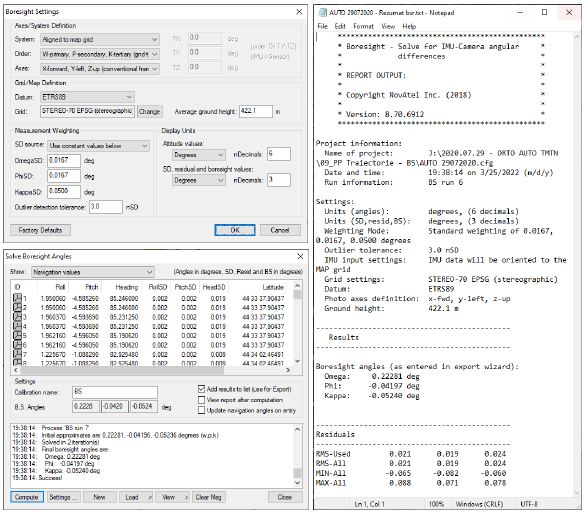
Figure 24 . Precise boresight calibration – setup and